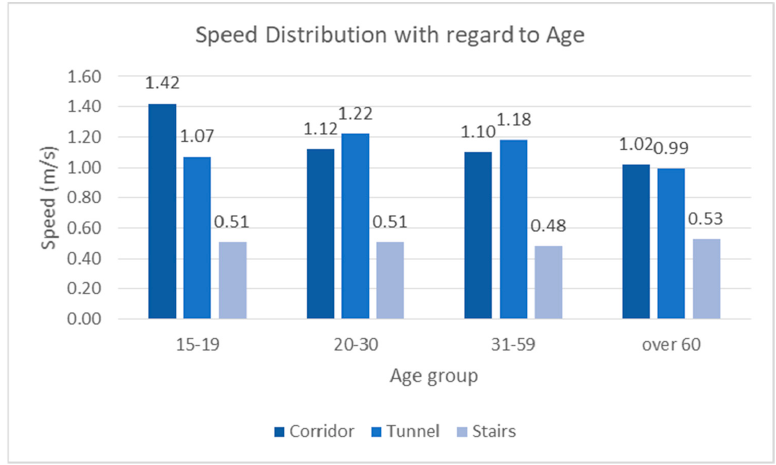
Figure 18. Speed distribution with regard to age group (clear environment).